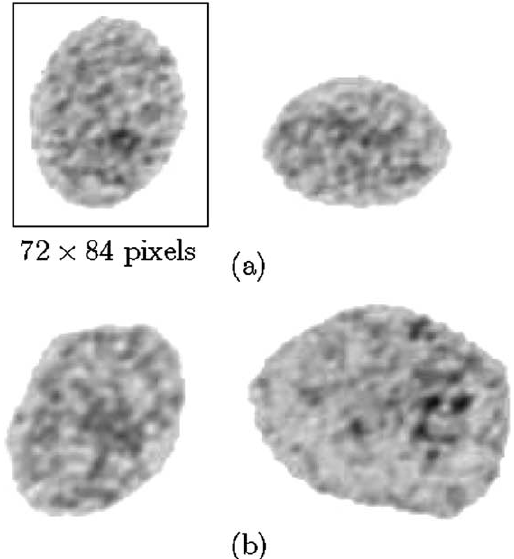
Fig. 1. Isolated cell nuclei (monolayers) from (a) a good prognosis case and (b) a poor prognosis case. ing correction was performed for each image field.